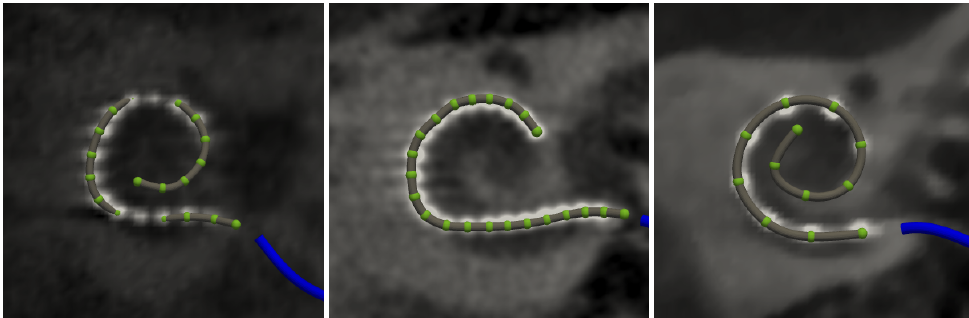
Figure 5. Electrode array detection in Nautilus has been developed and validated with Oticon Medical EVO electrode arrays ( left ) in mind. However, the same approach can be used with other electrode arrays. Example detection outputs for Cochlear Nucleus CI622 ( middle ), and MED-EL FLEX24 ( right ) cochlear implants